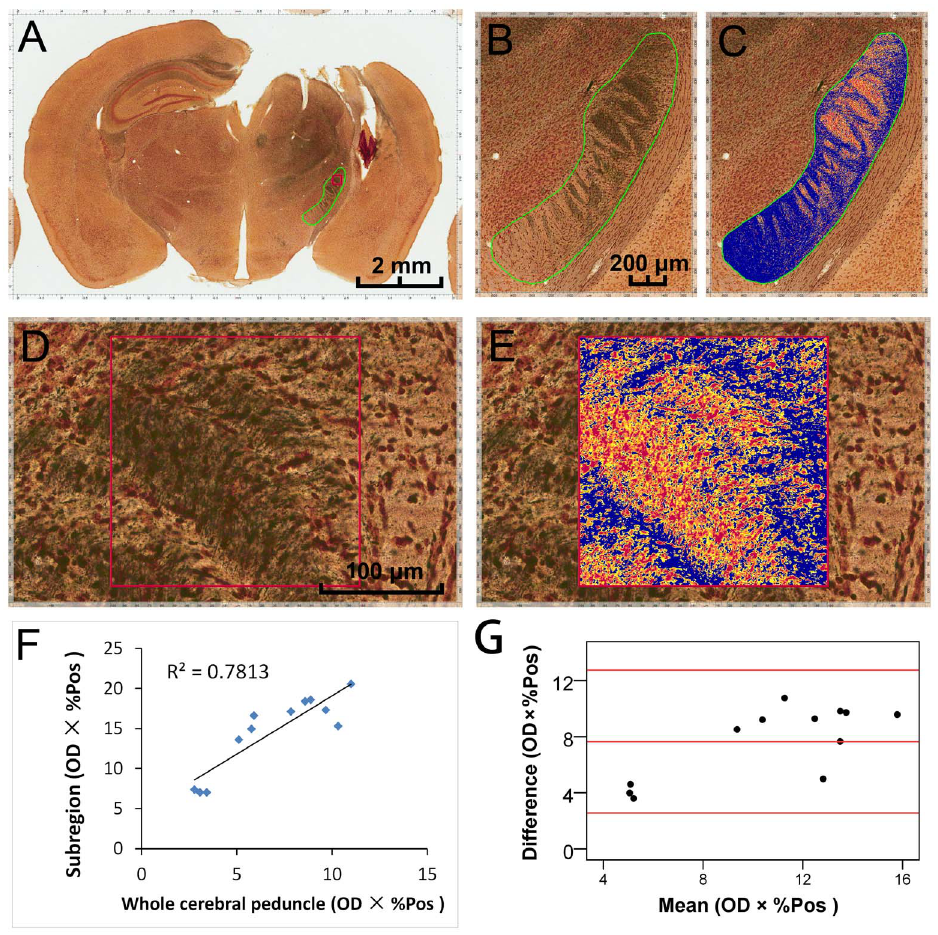
Figure 4. Algorithm-assisted analysis of neurodegeneration on silver stained CCI sections. Brain sections at Bregma 2 2.02 mm from mice subjected to CCI were processed with silver staining to reveal neuronal degeneration ( A ). The green and red outlines indicate the two ROI we chose: ipsilateral cerebral peduncle ( B ) and a 200 6 200 m m 2 subregion ( D ) in the rostral region of the cerebral peduncle. Application of color deconvolution algorithm resulted in generation of mark-up images ( C , E ), and the optical density (OD) multiplied by the percentage of positive staining (%Pos) of these two regions were achieved, separately. Although the Pearson correlation coefficient ( F ) showed a high degree of concordance (R=0.884, P=0.000, n=12) between OD 6 %Pos of both regions, the Bland-Altman difference plots ( G ) indicated that the data of the subregions were always higher than that of the whole cerebral peduncle. A: scale bar=2 mm; B, C: scale bar=200 m m; D, E: scale bar=100 m m.